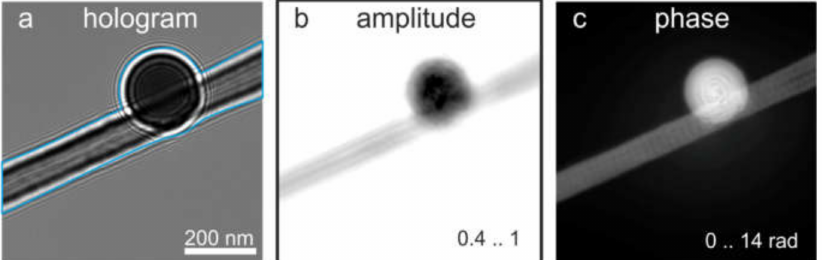
Figure 17. In-line hologram of a latex sphere and its reconstruction. ( a ) In-line electron hologram of the latex sphere recorded at the defocus 180 µ m, with 200 keV electrons in a TEM. The blue lines mark the area outside of which the transmission was set to 1 during the iterative reconstruction (support). ( b , c ) show the retrieved amplitude and phase distributions, respectively. Reprinted from [53], with permission from Elsevier.